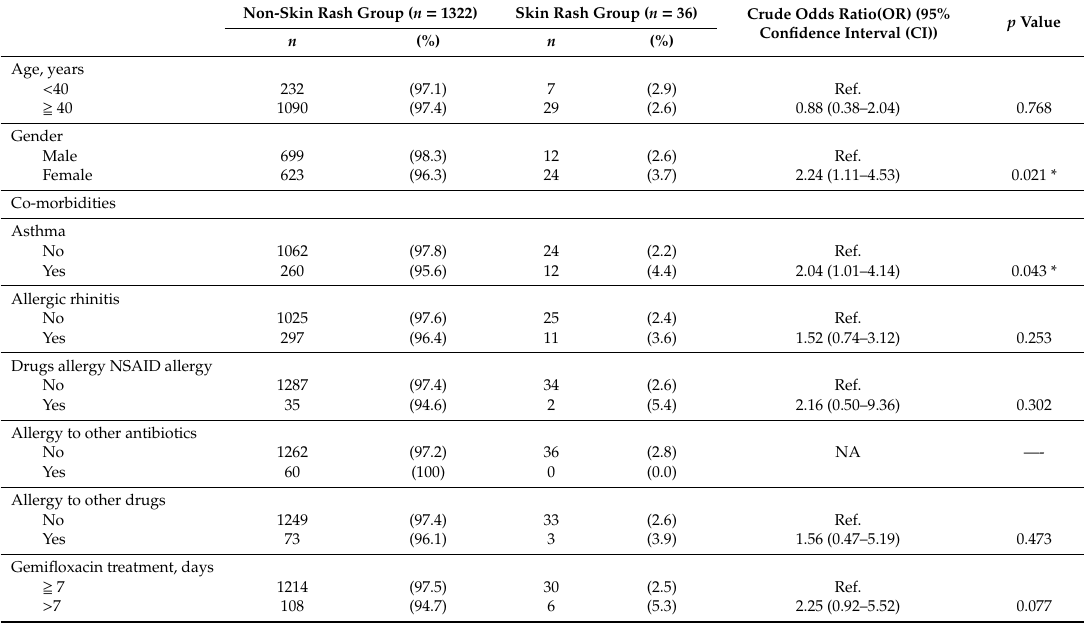
Table 1. Demographic data of patients with Gemifloxacin-induced skin eruptions in Kaohsiung Municipal Ta-Tung hospital from 1 January 2012 to 31 May 2016 ( n = 1358). Non-Skin Rash Group ( n = 1322)